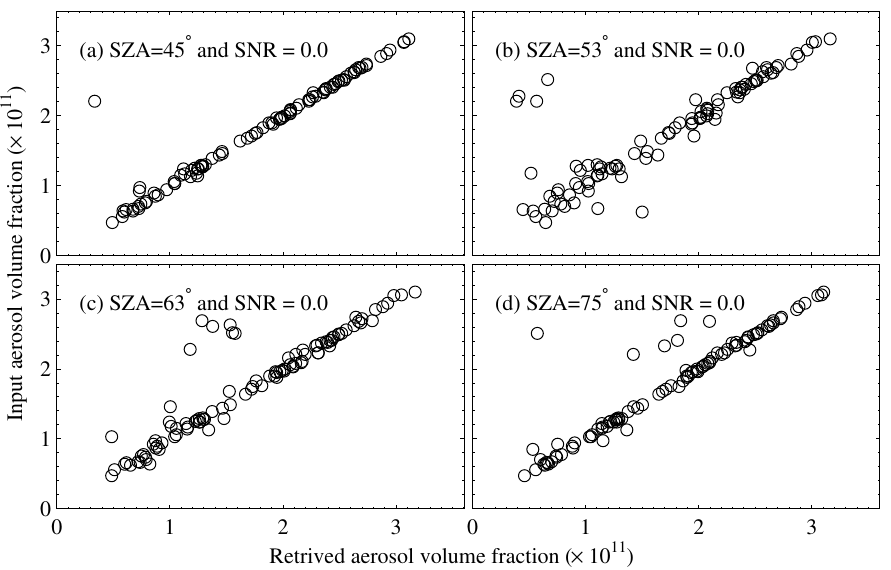
Figure 7. Comparison between input values and retrieved values for the aerosol volume fraction for different solar zenith angles (SZAs).